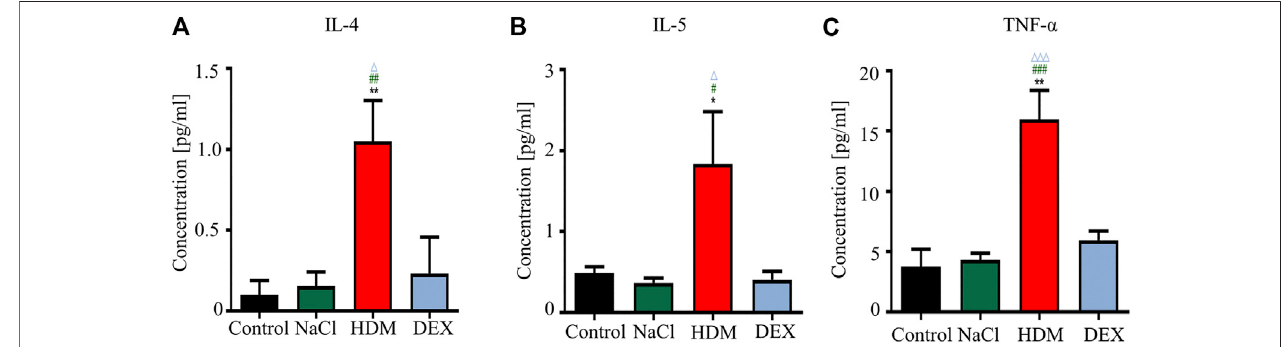
FIGURE 3 | The concentrations of IL-4, IL-5, and TNF- α were increased in the BALF in the HDM group. (A) IL-4, (B) IL-5, (C) TNF- α . * p < 0.05 and ** p < 0.01 betweenHDMgroupandControlgroup. n (cid:1) 5. # p < 0.05, ## p < 0.01and ### p < 0.001betweenHDMgroupandNaClgroup. △ p < 0.05and △△△ p < 0.001betweenHDM group and DEX group.